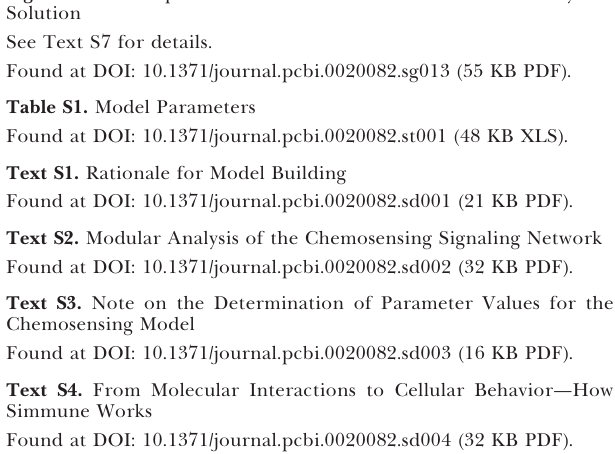
Figure S13. Comparison of Simmune’s Diffusion with Analytical Solution See Text S7 for